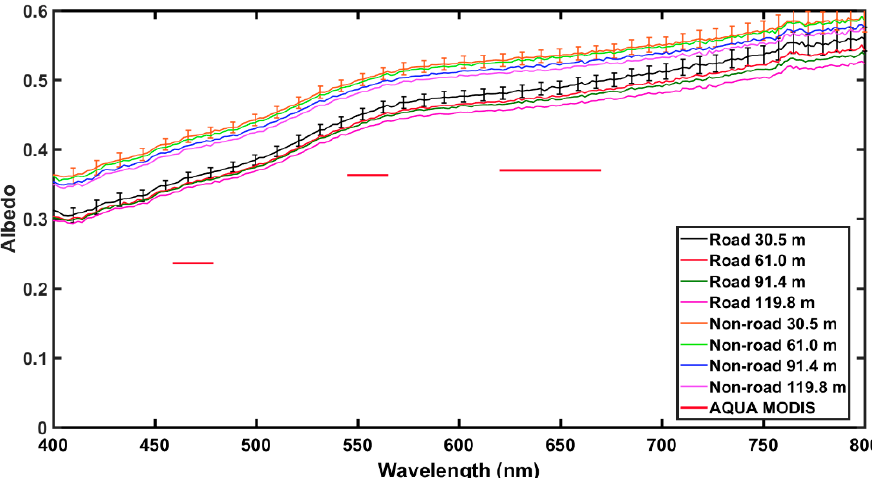
Figure 10. Albedometer measurements obtained over Nevada’s Black Rock Desert on 5 October 2017 at ~21:00 UTC and comparison to Aqua MODIS (Moderate Resolution Imaging Spectroradiometer) retrieved surface reflectance. Plotted are the average of five measurements taken at each height above ground level (AGL) over road and non-road. Uncertainty in the albedometer measurements was calculated according to Equation (2) and displayed for only two heights to prevent overcrowding in the figure. The mean uncertainty was ~0.01 across all wavelengths for each measurement across all heights.